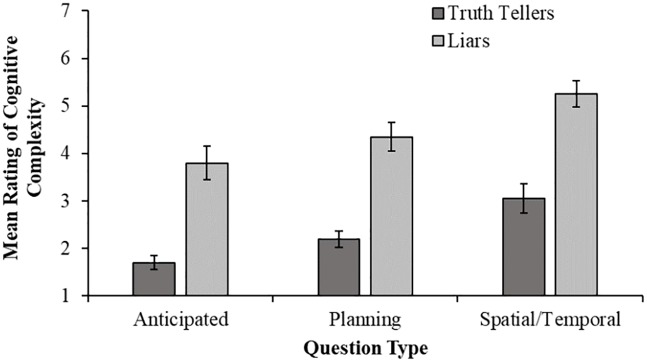
Mean ratings of cognitive complexity (1 = very easy, 7 = very difficult) given to each interview type for truth-tellers and liars separately.Error bars represent +/-1 SEM.